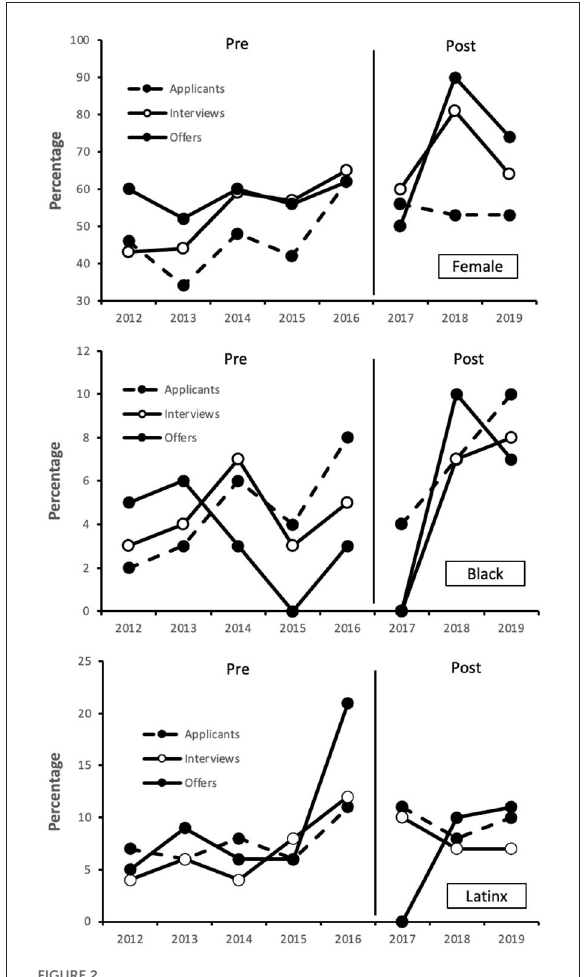
FIGURE2 Percentage of diverse applicants, interviewees, and hires per calendar year before and after implementation of search committee